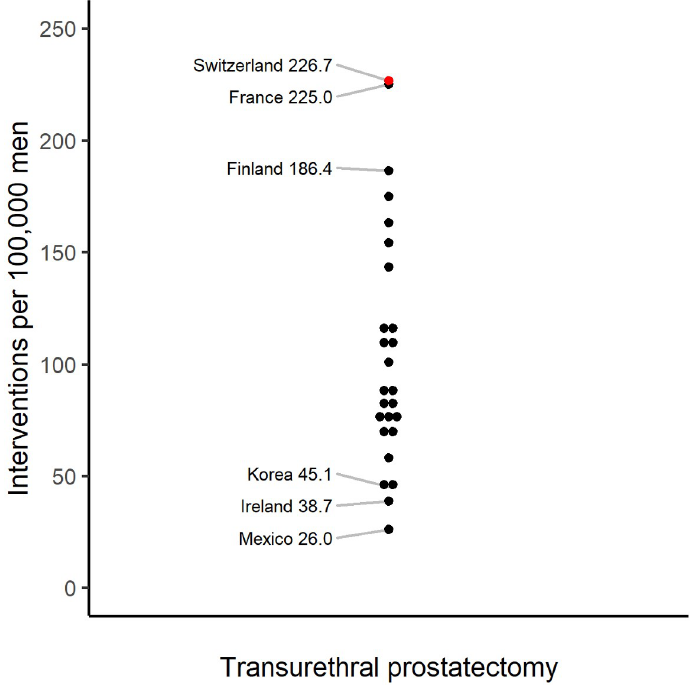
Fig 1. Comparison of transurethral prostatectomy rates across OECD countries (incl. Costa Rica) in 2018. Each dot represents the crude transurethral prostatectomy rate per 100,000 men in a given country. The red dot indicates